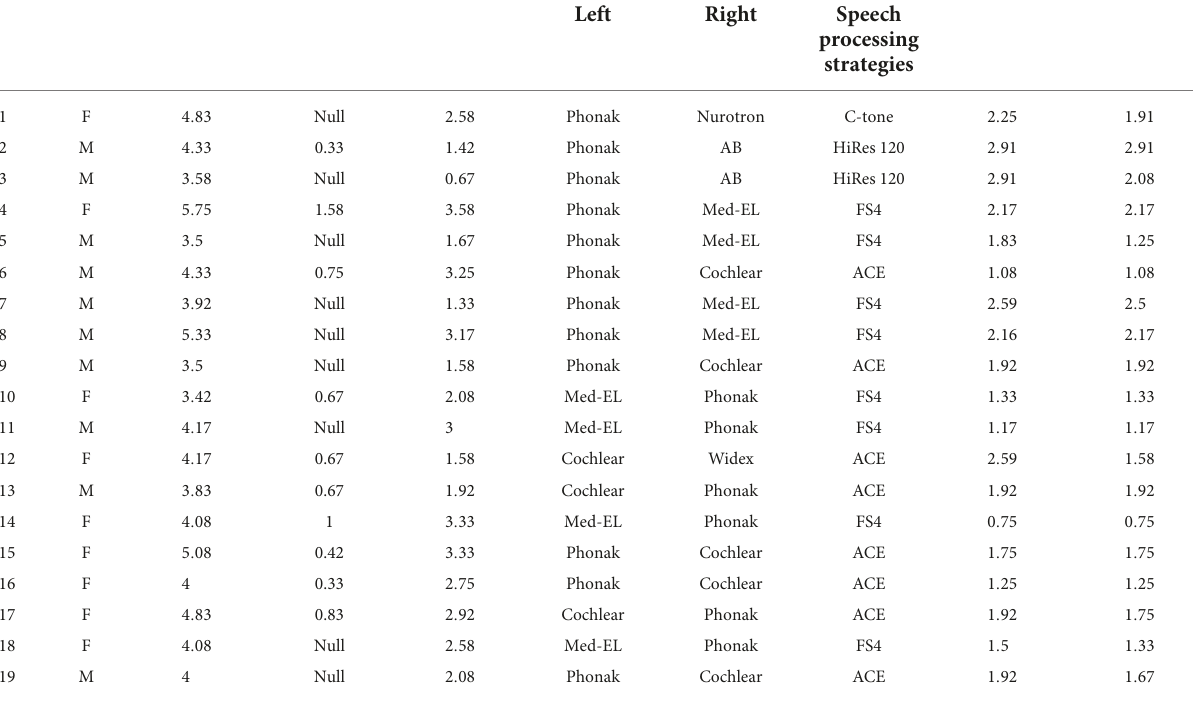
TABLE 1 Demographics of children with